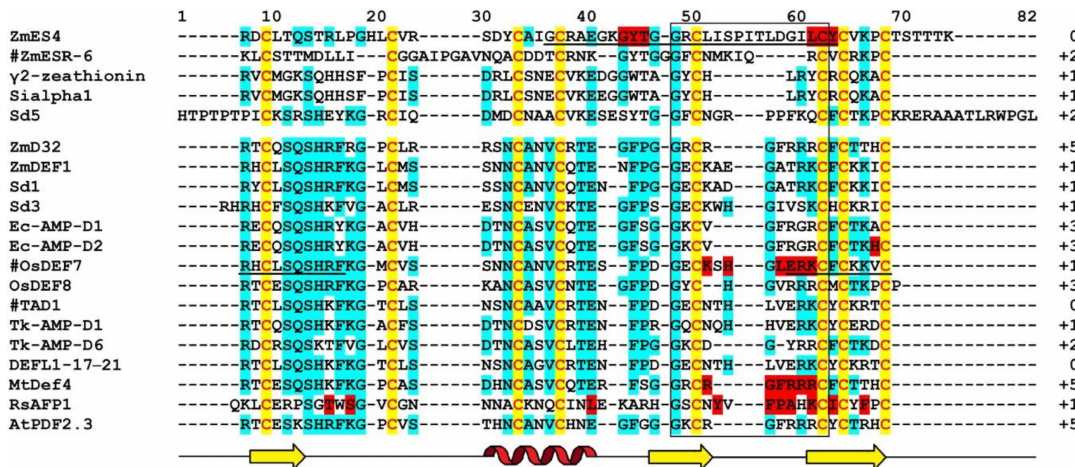
Figure 5. Sequence alignment of grass defensins with antifungal activity. Defensins MtDef4, RsAFP1, and AtPDF2.3 are included for comparison. Cysteine residues are shaded yellow, while identical amino acids are shaded cyan. Functionally significant residues are highlighted in red [25,79,94,95,98,99]. Regions important for antifungal activity are underlined. The position of β -strands (yellow) and the α -helix (red) are indicated below the figure. A black frame borders the γ -core. The γ -core charge values are shown on the right. The # symbol on the left indicates peptides possessing both antifungal and antibacterial